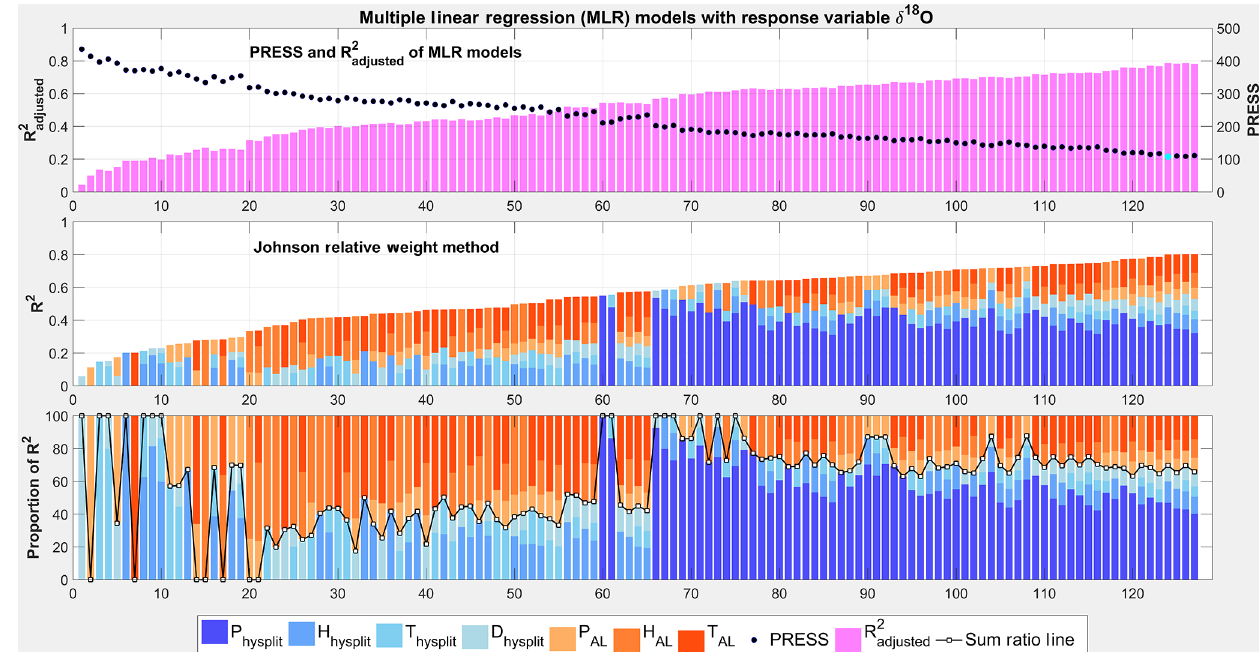
Figure 12. MLR with response variable δ 18 O and relative importance analysis applied for all possible subsets. The 127 MLR models are sorted according to their R 2 values in ascendant order. Colors represent the relative contribution (in %) of the predictors. The sum ratio line separates the contribution of local (in red and orange) and regional (in blue) factors. PRESS and adjusted R 2 values indicate the quality of the MLR model. The best MLR model depicted by the lowest PRESS (model 124, highlighted by the cyan dot) explains 80% of the δ 18 O variation ( R 2 =